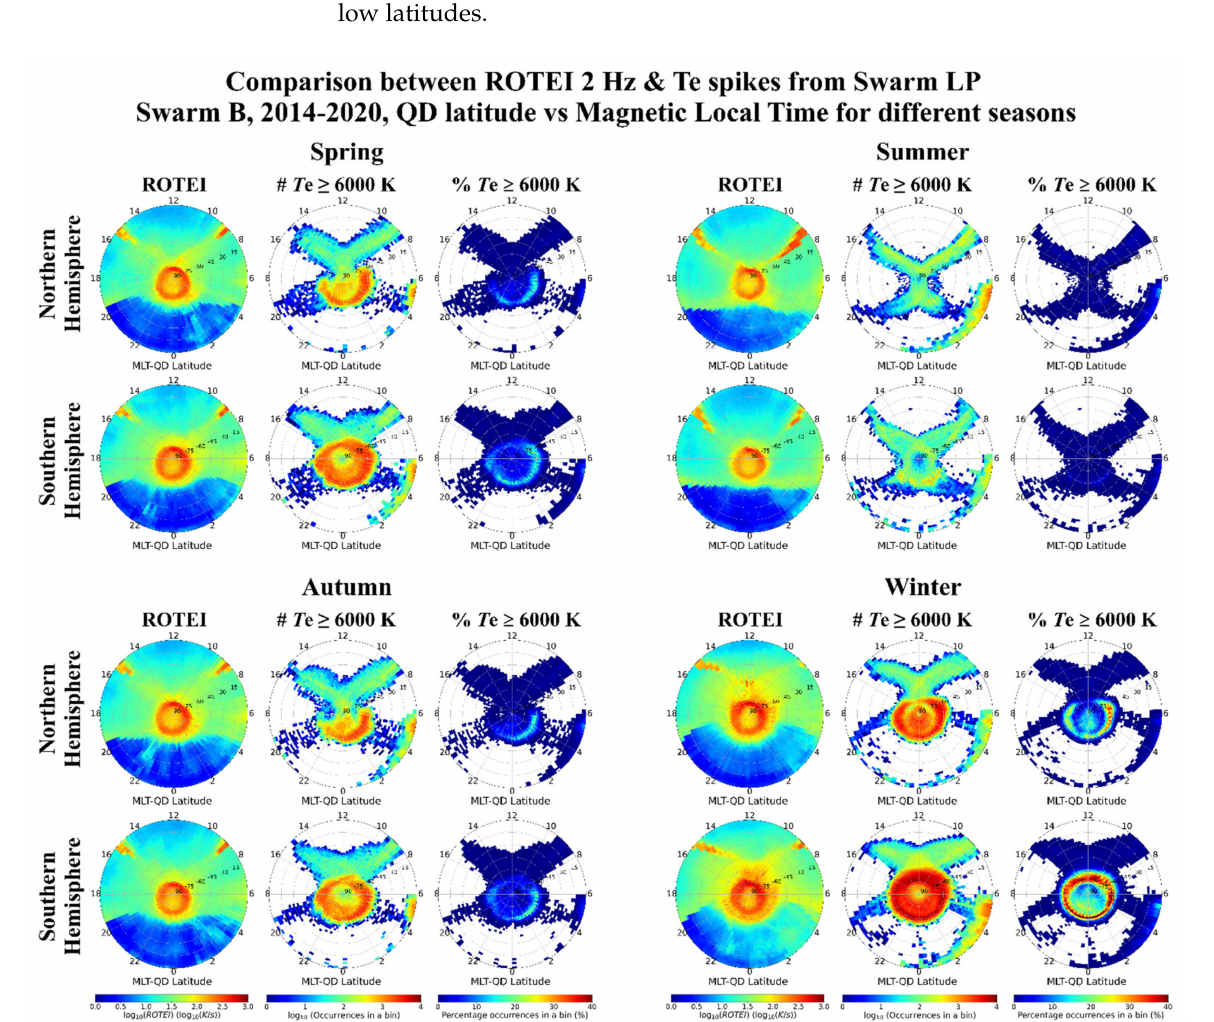
Figure 4. Comparison between ROTEI values shown in Figure 2 and T e spikes ( T e ≥ 6000 K) recorded by Swarm B from 2014 to 2020, for each season and for both hemispheres. Each panel contains the ROTEI mean values (first and fourth columns), the number of values satisfying the condition T e ≥ 6000 K in the bin (second and fifth columns), and the percentage occurrence of T e spikes in the bin (third and sixth columns). Data are binned in QD magnetic coordinates in polar projection; the bin size is (azimuth) 15 minutes in MLT, (radius) 2.5 ◦ in QD latitude, for the Northern and Southern hemispheres. Clockwise from the upper left panel, the spring, summer, winter, and autumn seasons are